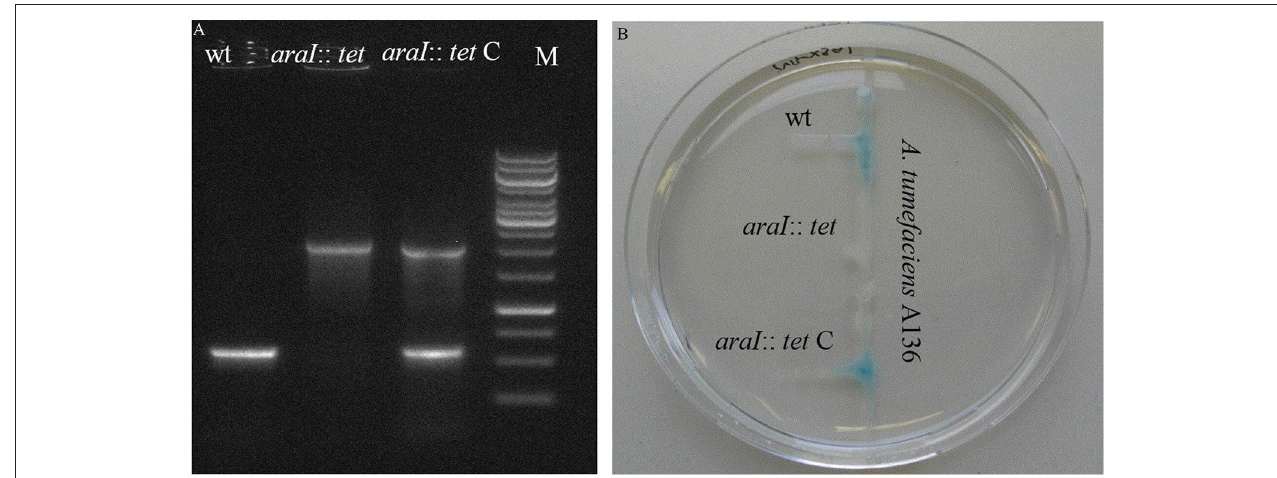
FIGURE 1 | PCR verification (A) and a galactosidase biosensor plate assay detecting AHL production (B) of the A. radicis N35 wildtype, araI knock-out mutant ( araI::tet ), and complemented araI knock-out mutant ( araI::tet C).